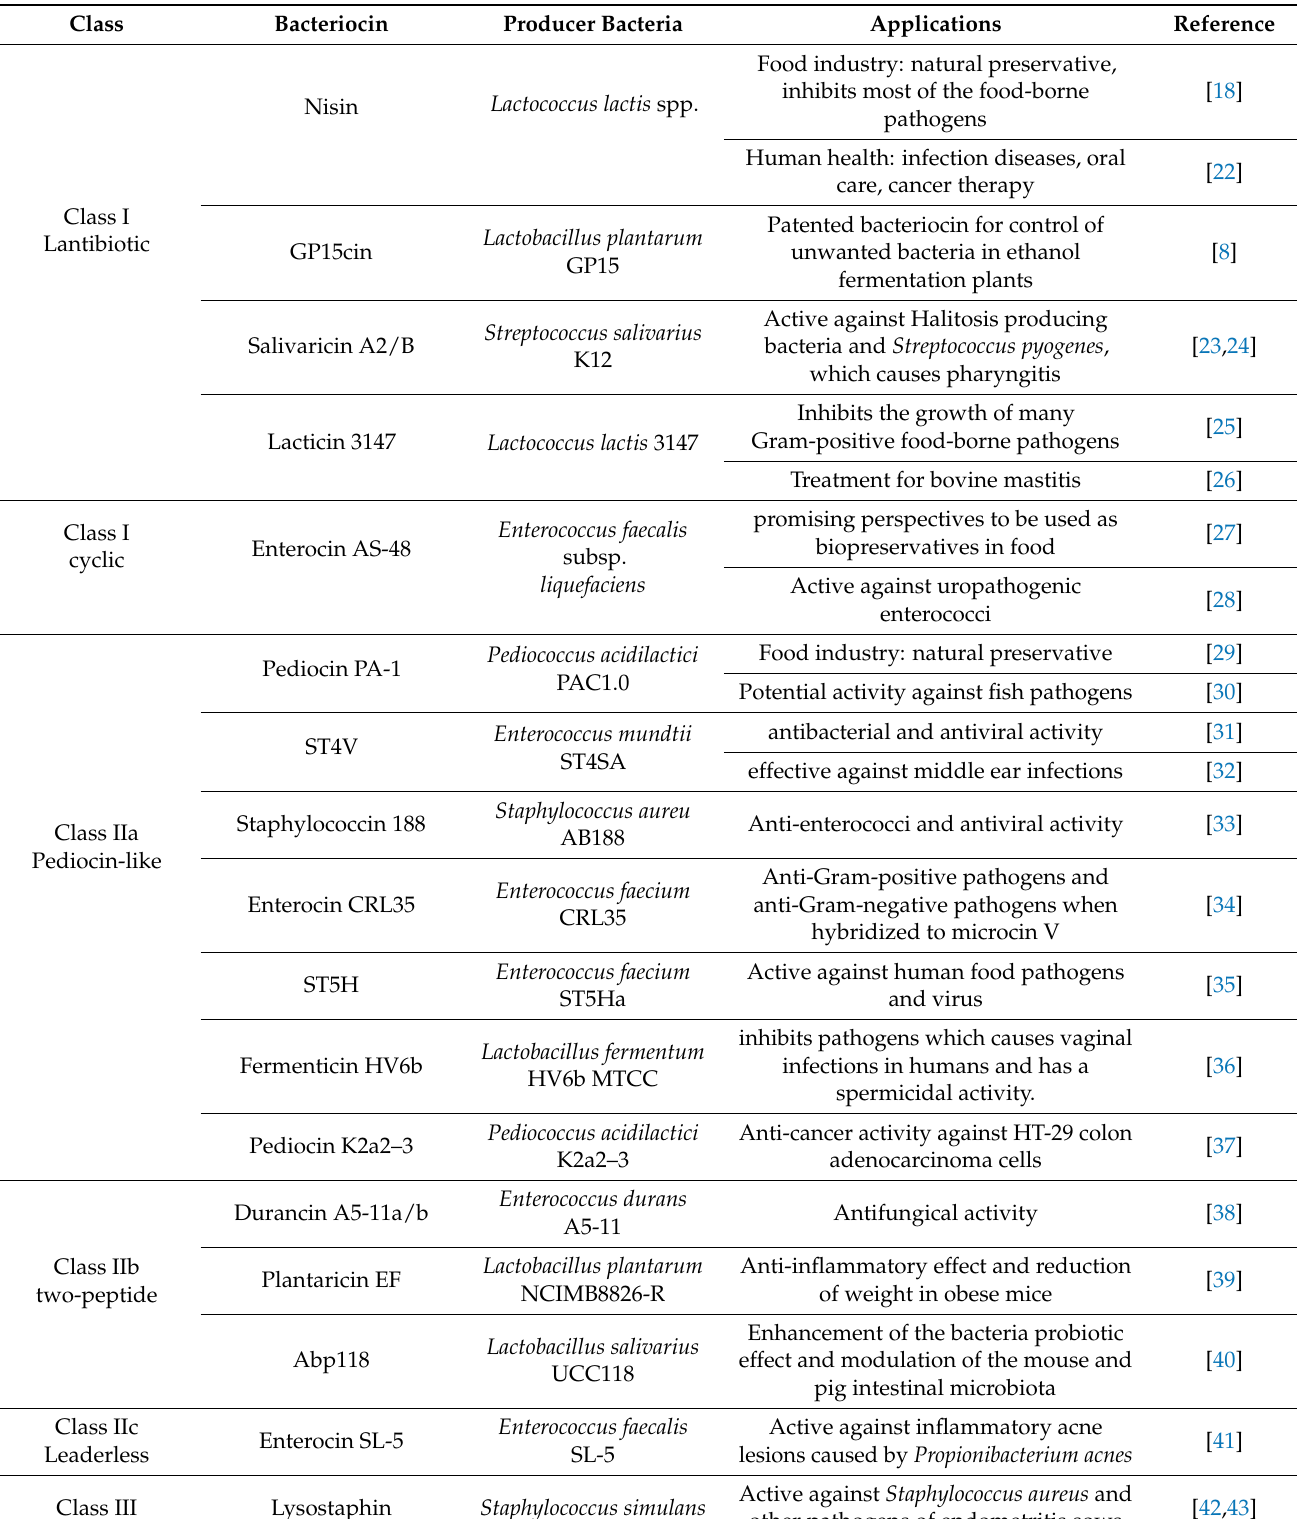
Table 1. Overview on the potential of LAB-bacteriocins